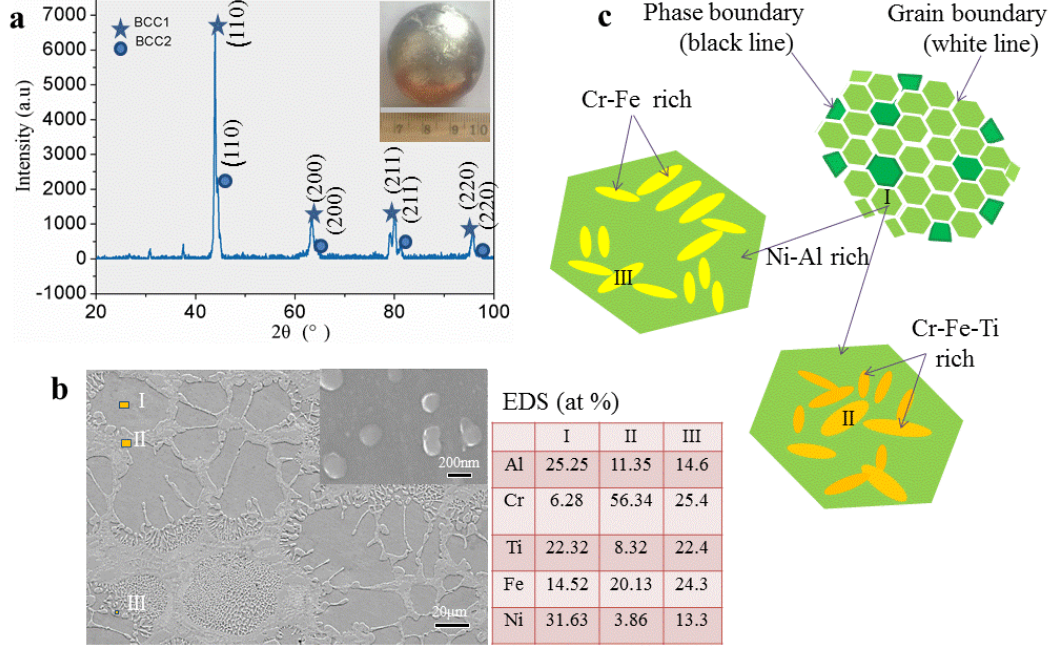
Figure 7. BSE images of selected AlCrTiFeNi alloy. ( a ) X-ray pattern sample; ( b ) SEM microstructure; ( c ) The schematics of the microstructure.